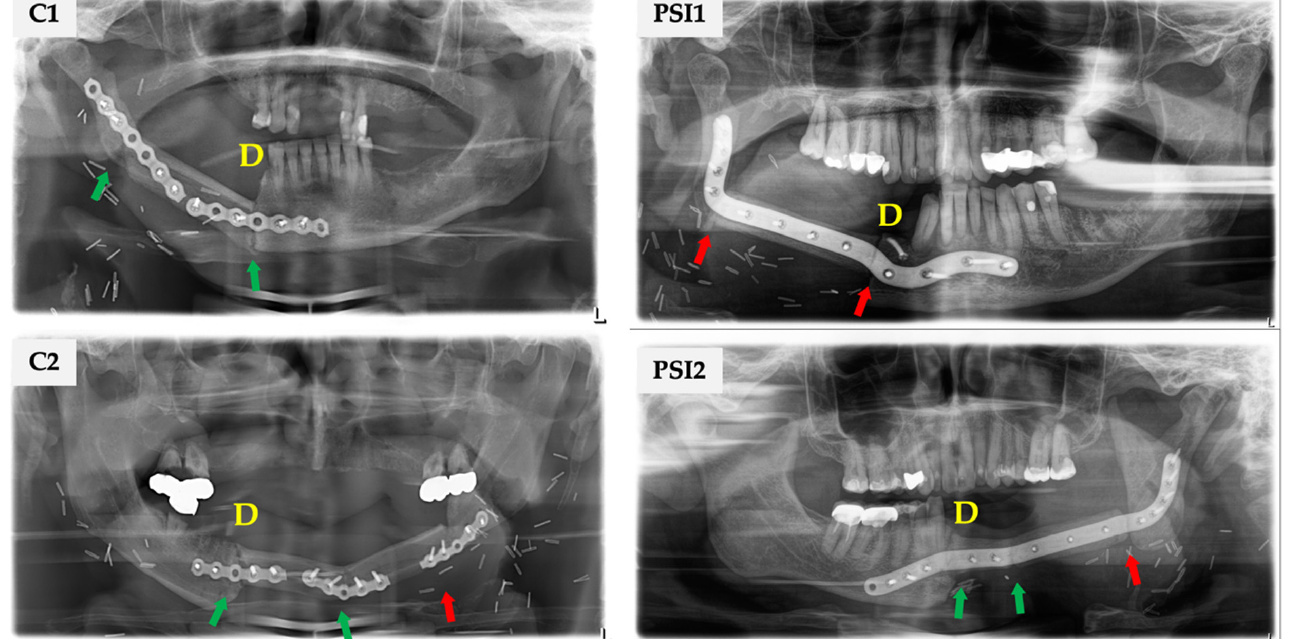
Figure 2. Note: D, distal end of fibula; green arrow: complete osseous union (COU); red arrow: incomplete osseous union (IOU). C1: Uni-segmental, lateral reconstruction of mandible. Two distinct mini-plates Unilock 2.0 system (DePuy Synthes CMF ® , Raynham, MA, USA) were used for internal fixation. Each junction was addressed with a single plate and locking screws. COU was assessed for the proximal (angle) and distal (anterior corpus) junction. C2: Bi-segmental, bilateral mandible reconstruction, and conventional stabilization. IOU of the proximal transition zone at the posterior corpus region, while the distal (canine) and inter-segment junctions showed COU. PSI1: Uni-segmental, lateral mandible reconstruction and stabilization with PSI (KLS Martin, Tuttlingen, Germany). IOU of the proximal (angle) and distal (anterior corpus) transition zone. PSI2: Bi-segmental, bilateral mandible reconstruction and stabilization with PSI. IOU of the proximal junctions at the posterior corpus region, while the distal (canine) and intersegmental junctions show COU.